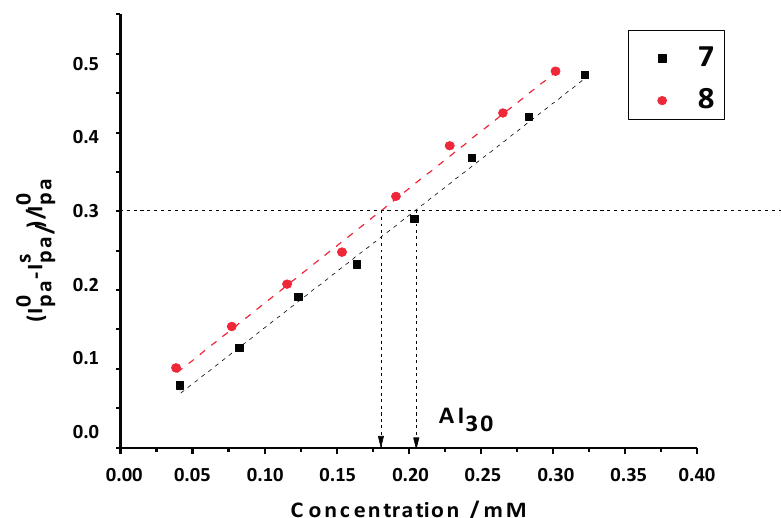
Figure 6. Graphs of decreasing anodic peak current between the control (I pa °) and the substrate (I pas ) against increasing concentrations of substrate, in this case, compounds 7 and 8 ; AI 30 is the concentration of inhibition at 30% of superoxide radical.